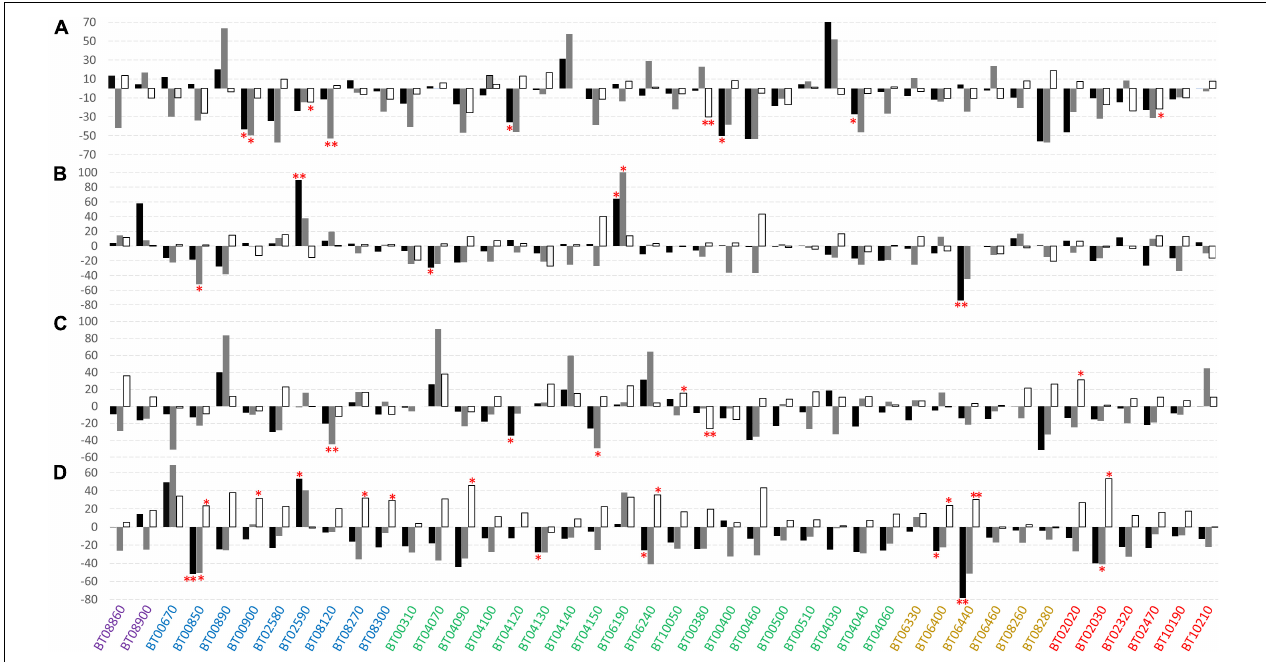
FIGURE 4 | Phenotypic differences between water and nitrogen stress conditions compared to the control for the 42 tomato varieties tested in two locations. Values are expressed as differences in percentage between the mean of the stress condition with respect to the control. Different colored bars indicate different traits: fruit weight in black, total yield in gray, and soluble solids in white. (A) Nitrogen stress condition in Italy, (B) nitrogen stress condition in Spain, (C) water stress condition in Italy, and (D) water stress condition in Spain. The color of the accessions indicates the related cultivar type as follows: breeding lines (BL) in purple; elite cultivars (CL) in blue, landraces for the fresh market (FM) in green, heirlooms (HL) in dark orange, long shelf-life landraces (LS) in red. Single and double asterisks indicate significant differences with the control at p < 0.05 and p < 0.01,